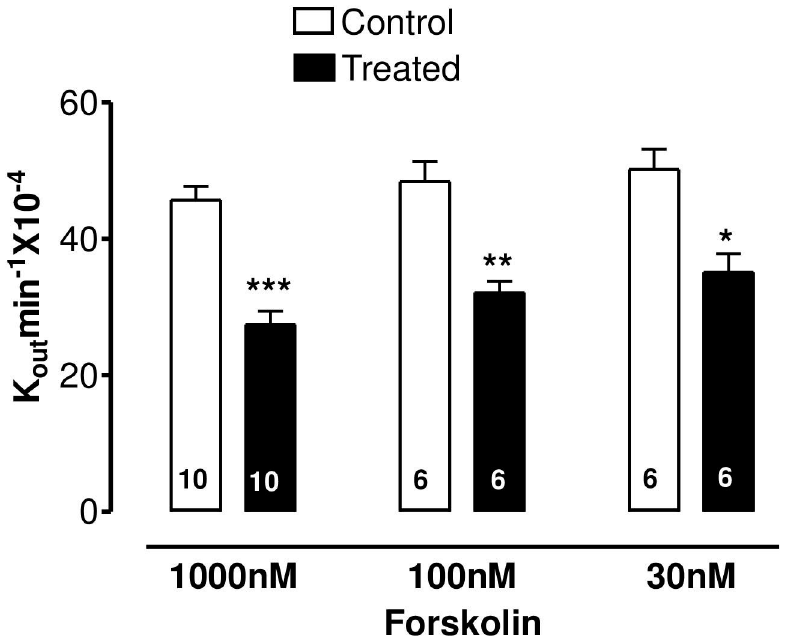
Fig 2. The effect of forskolin on AH formation rate in the bovine isolated perfused eye measured by fluorescein dilution technique. AH formation rate was expressed as the rate constant (K out .min -1 × 10 − 4 ), defined as the slope of the regression line drawn on LN (Log e ) of the changes of fluorescence with time (min). Each value is a mean s.e.mean of the number (n) of experiments shown at the base of each column. In order to eliminate individual variation, control and treated data were obtained from the same eye. AH formation rate measured during the first 30 min prior to drug application was taken as the control value. AH formation rate for the subsequent 40–60 min after establishment of drug effects was taken as the treated value. Note that after addition of drug, 20 min stabilization period was allowed to establish drug effect. Significance of differences from controls; � p < 0.05, �� p < 0.01 and ��� p < 0.001.